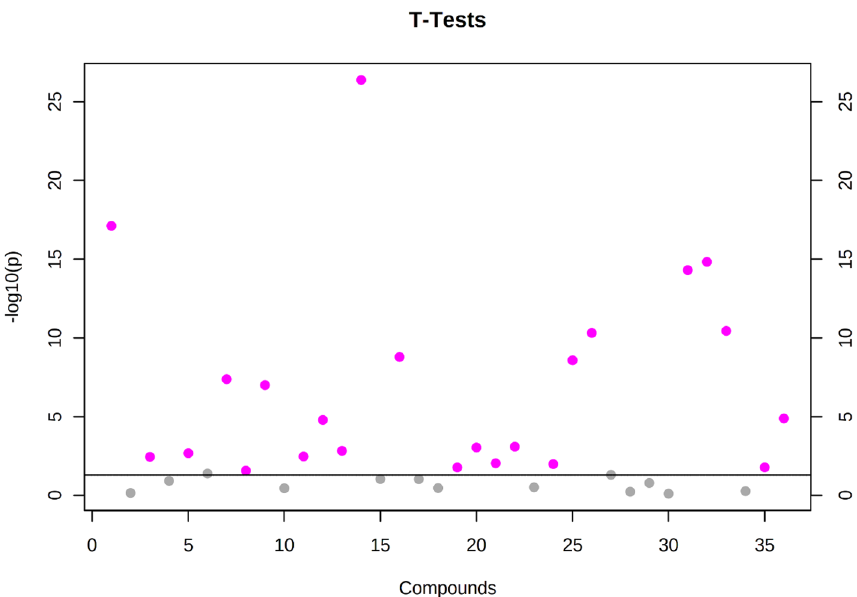
Figure 3. Important features selected by t-tests with threshold 0.1. The pink circles represent features above the threshold. Note the p values are transformed by − log10 so that the more significant features (With smaller p values) will be plotted higher on the